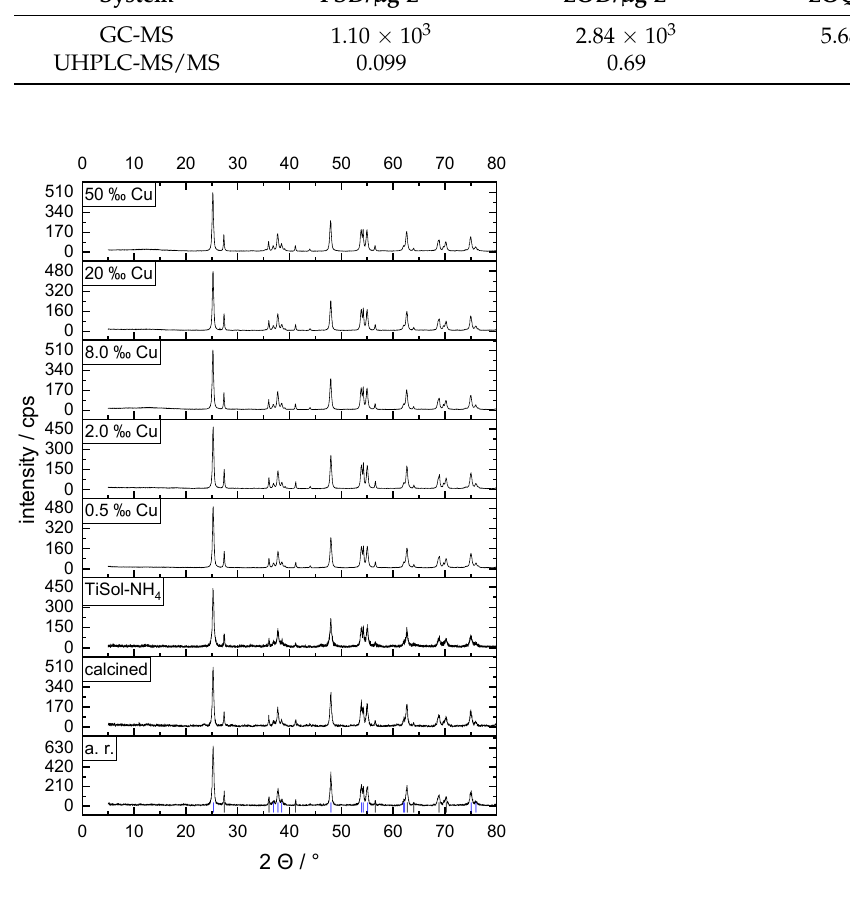
Figure 3. Powder X-Ray diffraction (XRD) pattern of different P25 samples; a. r.: P25 as received; calcined: ϑ = 500 ◦ C, t = 2 h; TiSol-NH4: calcined P25 [ m = 150 mg] combined with binder [ V = 1 mL] and ethylene glycol [ V = 50 µ L] and calcined; 0.5‰ Cu—50‰ Cu: a. r. P25 impregnated with copper acetate solution [x Cu = 0.5, 2, 8, 20, 50‰; x = n Cu n Ti − 1 ] and calcined; at the bottom, there is a reference diffraction pattern Table 2. Lattice parameters and phase composition, based on the Rietveld method for the crystalline anatase ‐ type and rutile ‐ type phase of different P25 samples, according to the XRD measurements (Figure 3); a. r.—P25 as received; calcined ( ϑ = 500 °C, t = 2 h); TiSol ‐ NH 4 (calcined P25 [ m = 150 mg] combined with binder [ V = 1 mL] and ethylene glycol [ V = 50 μ L] and calcined; 0.5‰ Cu—50‰ Cu (a. r. P25 impregnated with copper acetate solution [x Cu = 0.5, 2, 8, 20, 50‰; x = n Cu n Ti − 1 ] and calcined). Lattice Parameters/Å Phase Composition/wt.%